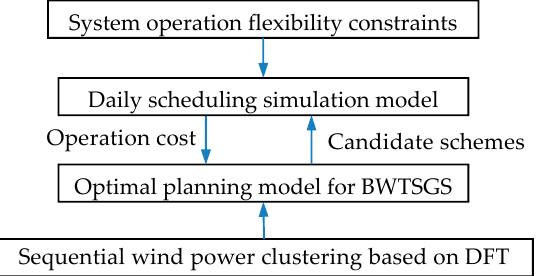
Figure 3. The proposed optimal planning model for a BWTSGS.